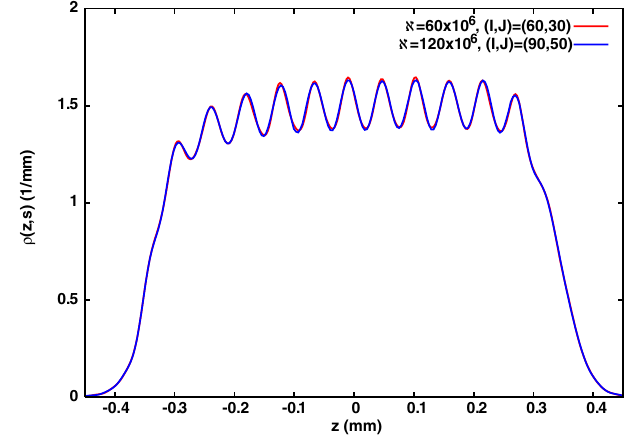
FIG. 18. (Color) Comparison of the longitudinal spatial density ¼ 200 (cid:4) m at s ¼ s for the set of parameters N for (cid:2) f 0 ¼ 60 , J ¼ 30 and N ¼ 120 (cid:7) 10 6 , I 60 (cid:7) 10 6 , I 1 1 2 ¼ 50 J 2